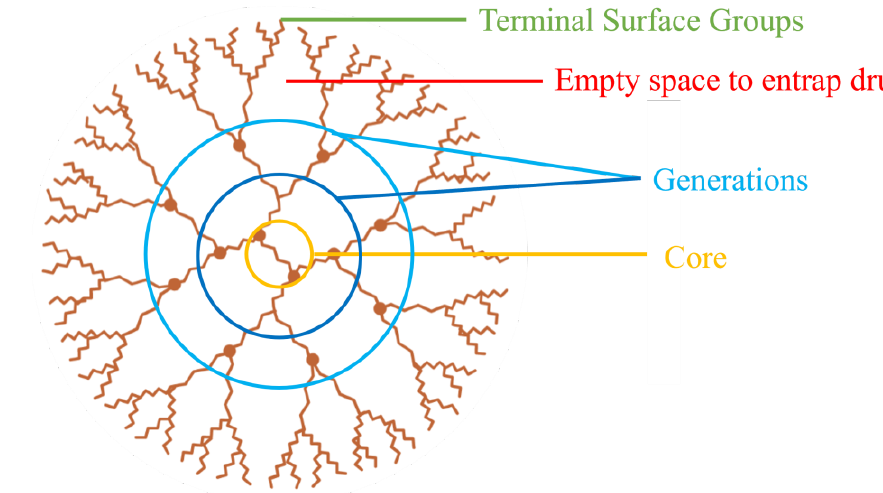
Figure 2. Structure of dendrimers.